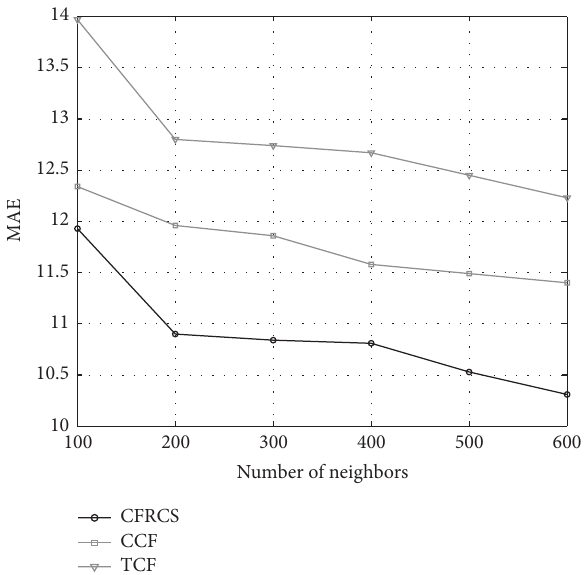
Figure 5: MAE of three algorithms on the standard data set.